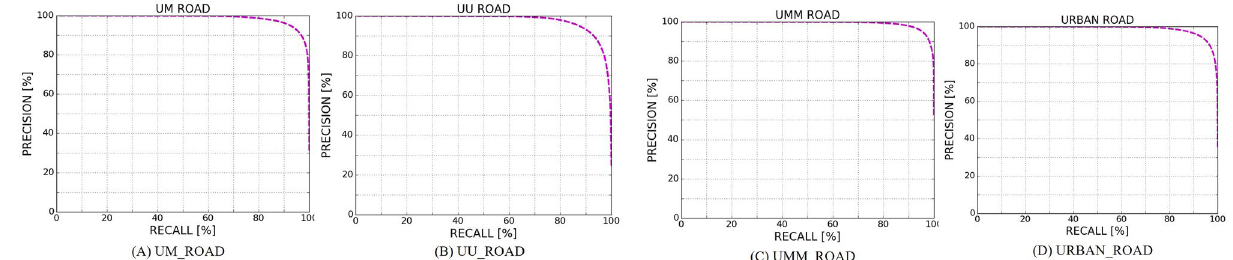
Figure 8. Precision–recall curves from the evaluation server.